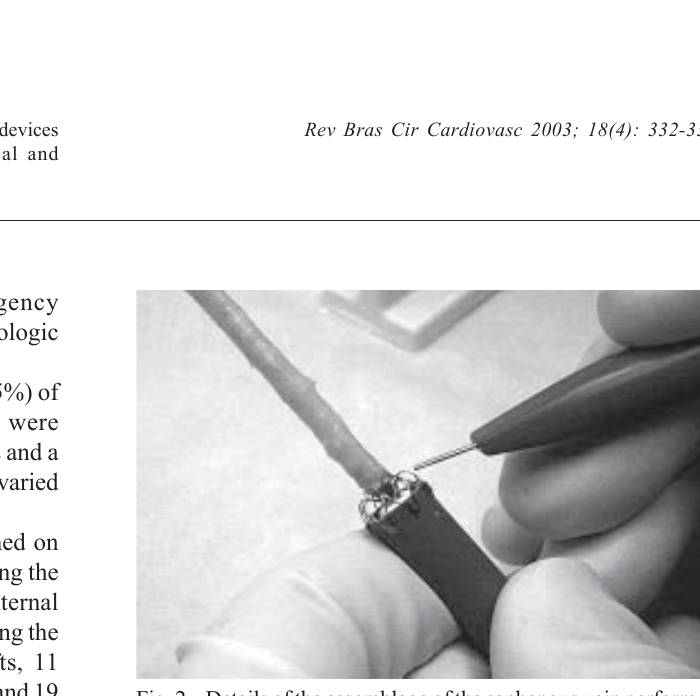
Fig. 2 – Details of the assemblage of the saphenous vein performed on a bench